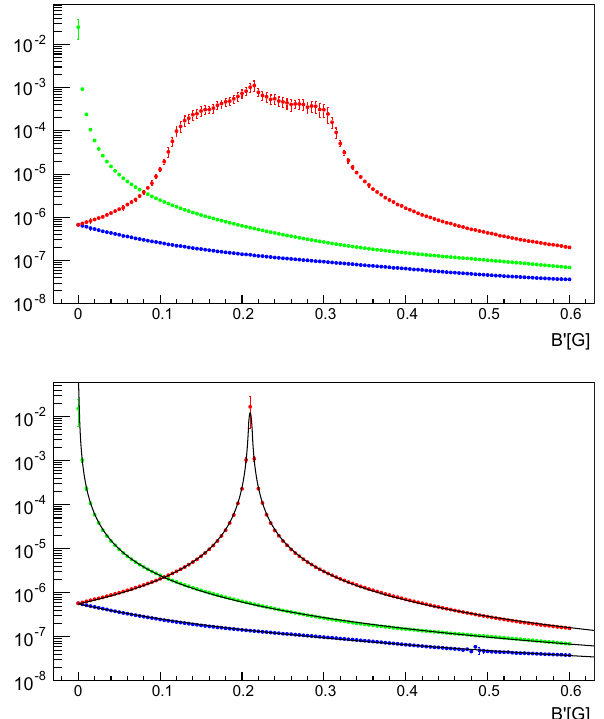
Fig. 4 Upper panel: Red and blue points show results of MC simula- tion respectively for S + ( B (cid:2) ) and S − ( B (cid:2) ) in our trap with B c = 0 . 21 G, and green points results for S 0 ( B (cid:2) ) (when magnetic field in trap is van- ishing, B = 0). Lower panel: The results of the same MC simulations the case of homogeneous magnetic field B = 0 . 21 G and B = 0. Black solid curves show the results obtained via empirical formula (6), in perfect coincidence with the MC results